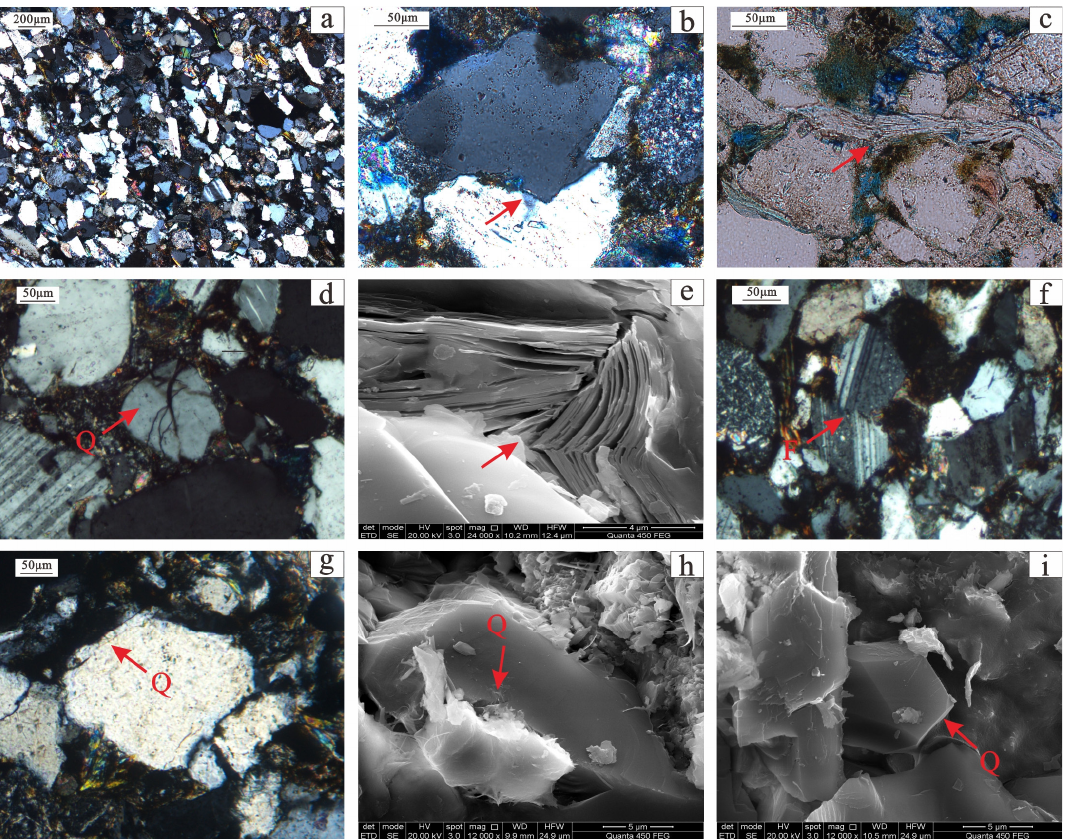
Figure 5. Compaction and quartz cementation of the Chang-7 Member in the Ordos Basin (Q: quartz; F: feldspar). ( a ) Z187, 1589.0 m, directional arrangement of clastic particles; ( b ) X270, 2042.97 m, concave–convex contact; ( c ) L190, 2259.24 m, mica-bending deformation; ( d ) N105, 1521.9 m, quartz particle breakage; ( e ) X318, 2020.8 m, mica fracture; ( f ) Y474, 2221.3 m, feldspar fracture; ( g ) N229, 1685.58 m, quartz overgrowth; ( h ) Z225, 1774.5 m, quartz overgrowth; ( i ) L337, 2284.3 m, authigenic- quartz-filled pores.